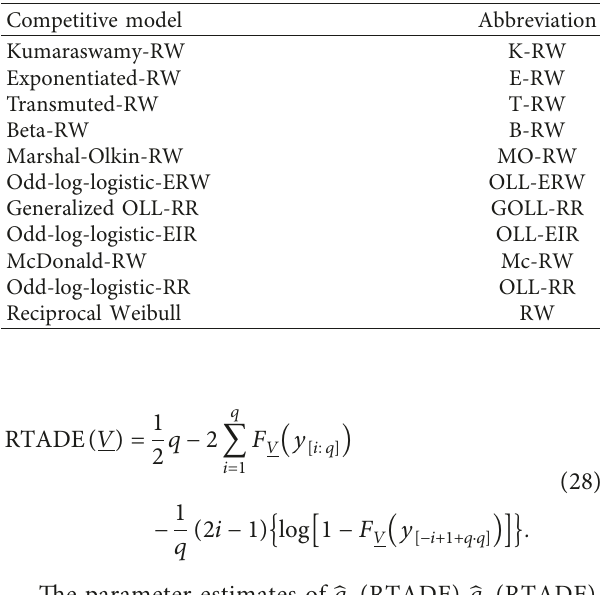
� 0.9, a � 0.9, and a 1 2